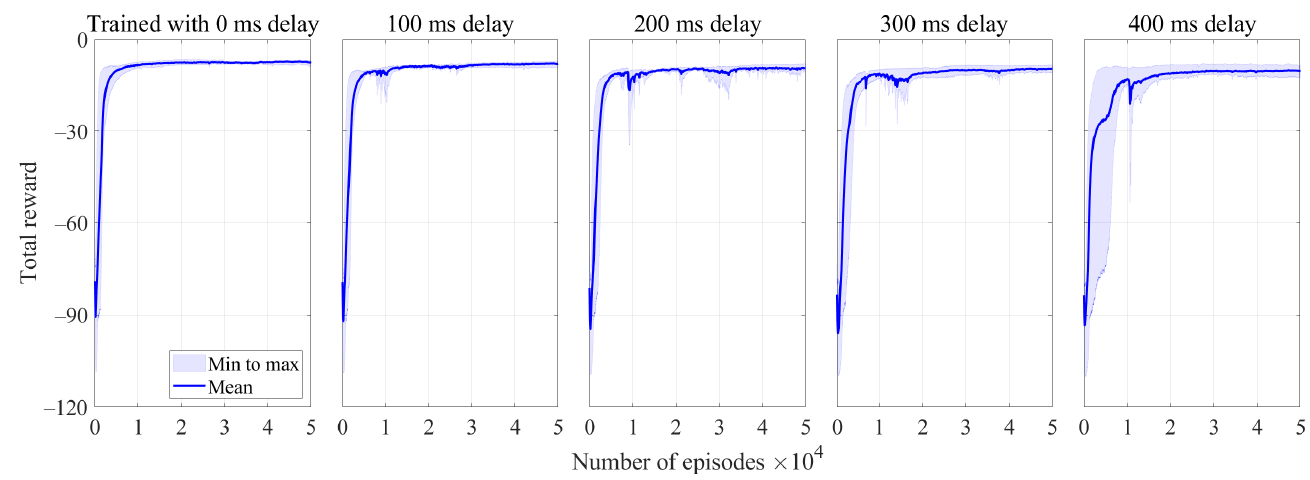
Figure 6. Learning curves. The solid lines are mean learning curves. The shaded areas are the minimum to maximum ranges over 5 random